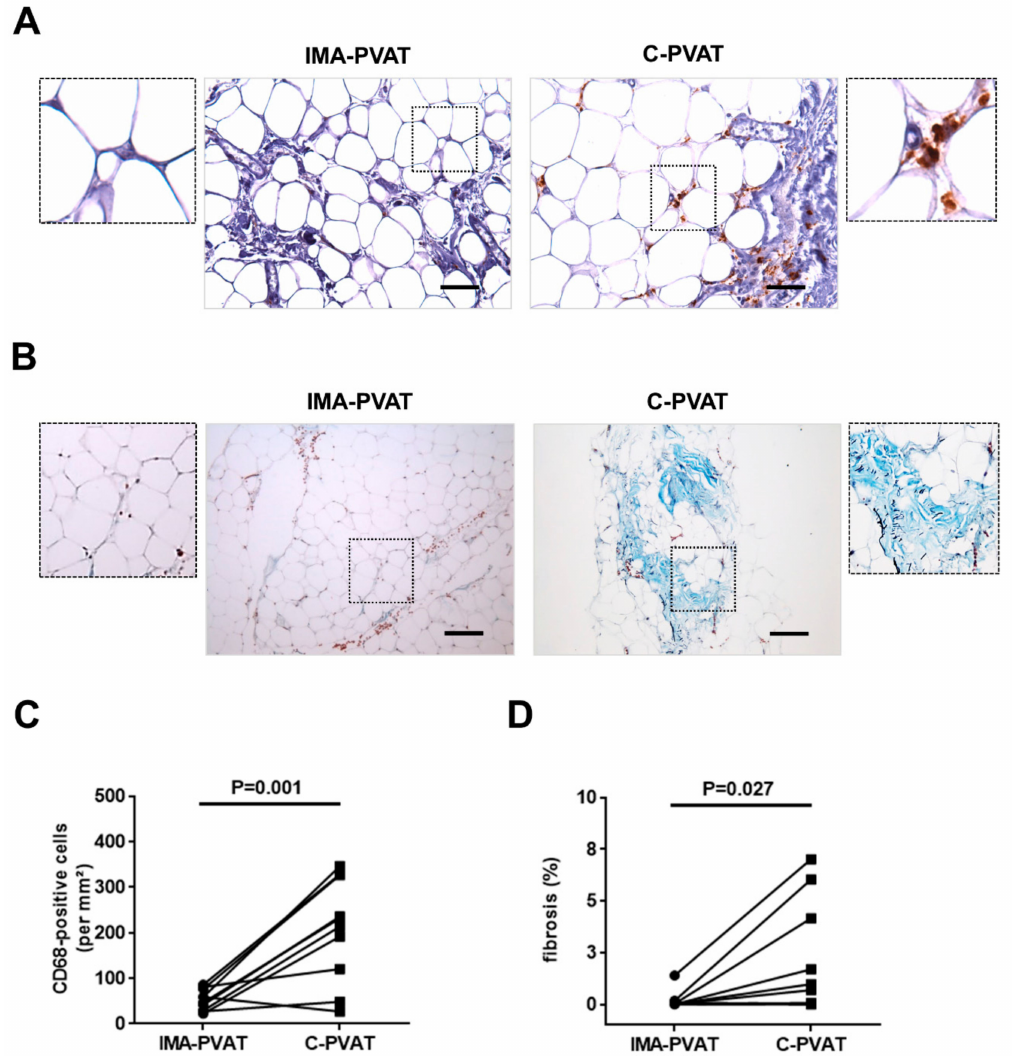
Figure 3. Fibrosis and inflammation in PVAT. ( A ) Immunohistochemical detection of CD68 in IMA-PVAT and C-PVAT. Size bars represent 50 µ m. ( B ) Masson trichrome stain in IMA-PVAT and C-PVAT. Size bars represent 200 µ m. ( C ) Quantification of the number of CD68-immunopositive cells per mm 2 . ( D ) Quantification of the percentage of fibrotic area in n = 10 patients with coronary artery disease (CAD). Paired IMA-PVAT ( (cid:8) ) and C-PVAT ( (cid:4) ) values in individual patients are connected with a line. Statistical analysis was performed using Student’s paired t -test ( C ) or Wilcoxon matched-pairs signed rank test ( D